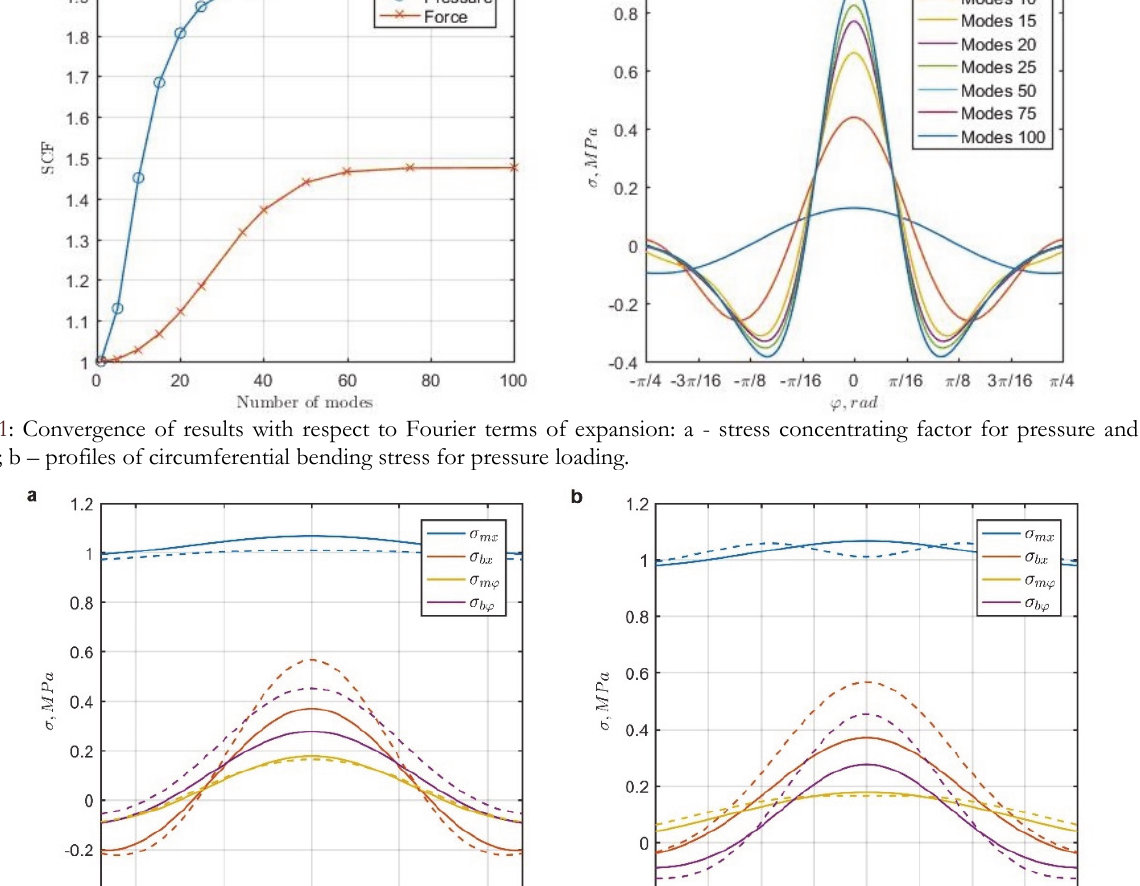
Figure 2: Comparison with FEM solution for axial force loading: R=400mm, h =10mm, ξ =0.5h, solution; FEM solution.